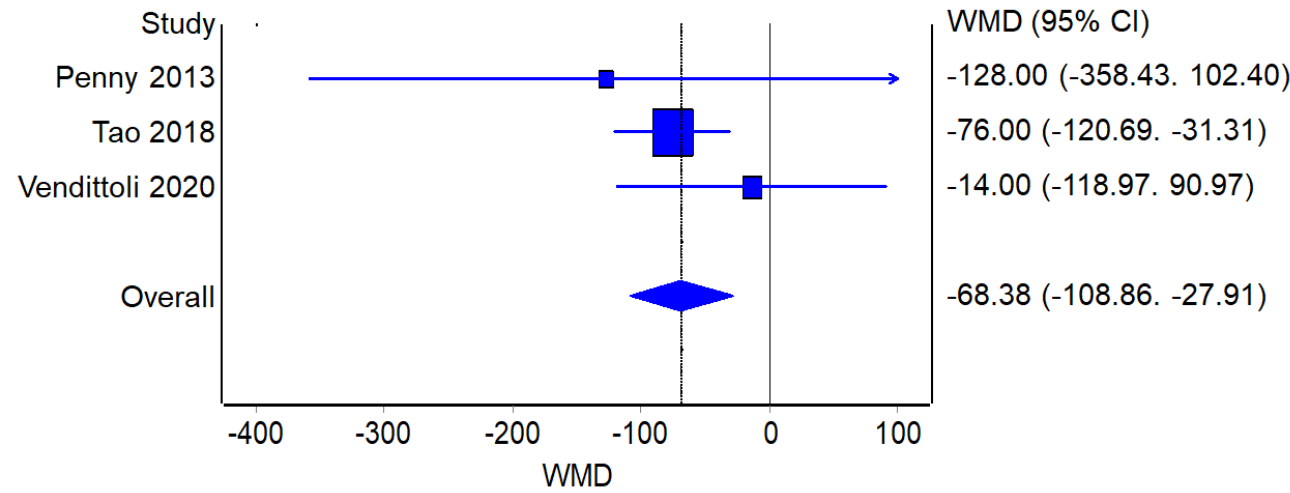
Figure 7. Blood Loss: Forest plot of the individual studies and pooled mean difference for blood loss, including a 95% confidence interval. The size of the squares shows the weight of the study [17–19,25,26,28,29,31].